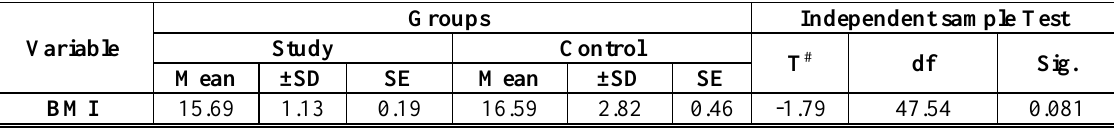
Table 4: The BMI difference among the study and control groups.